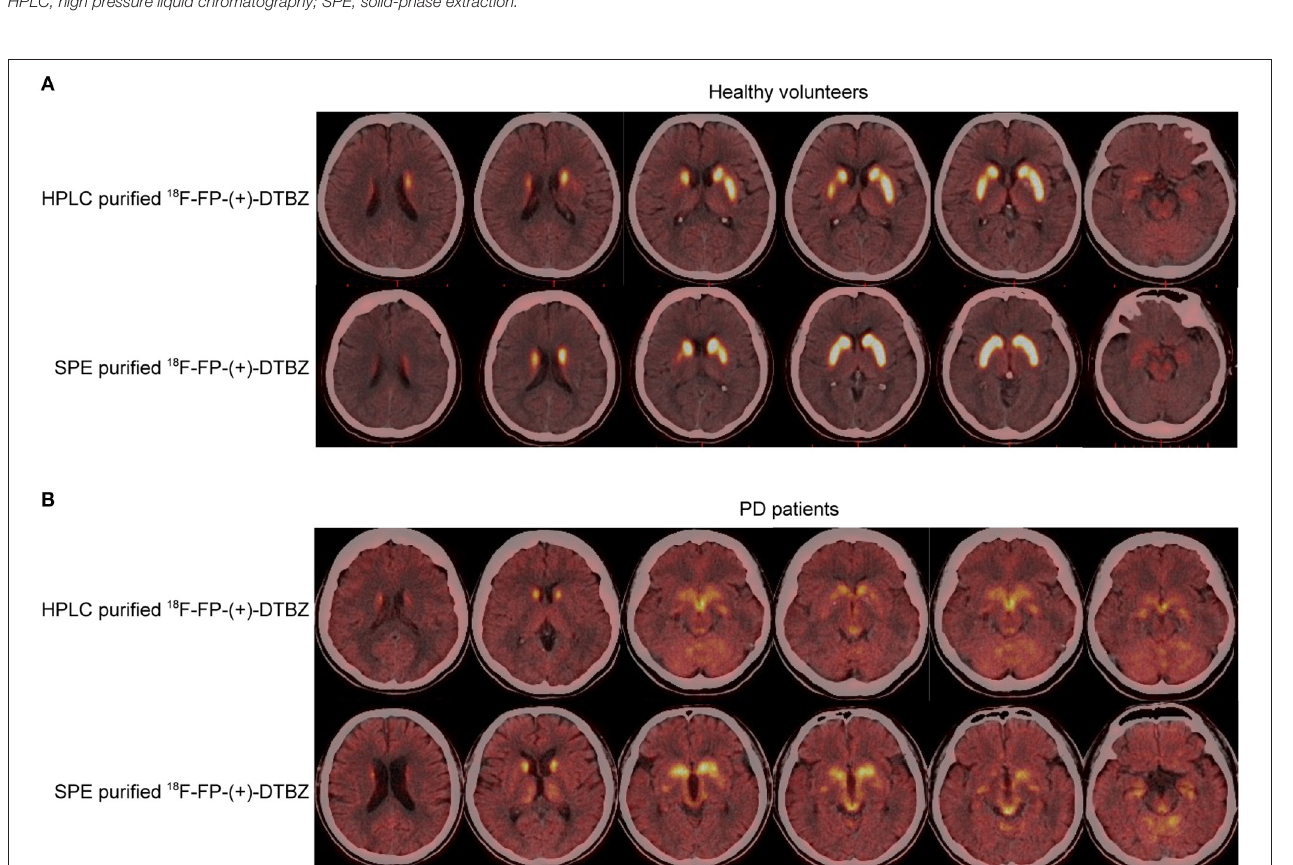
Frontiers in Medicine |